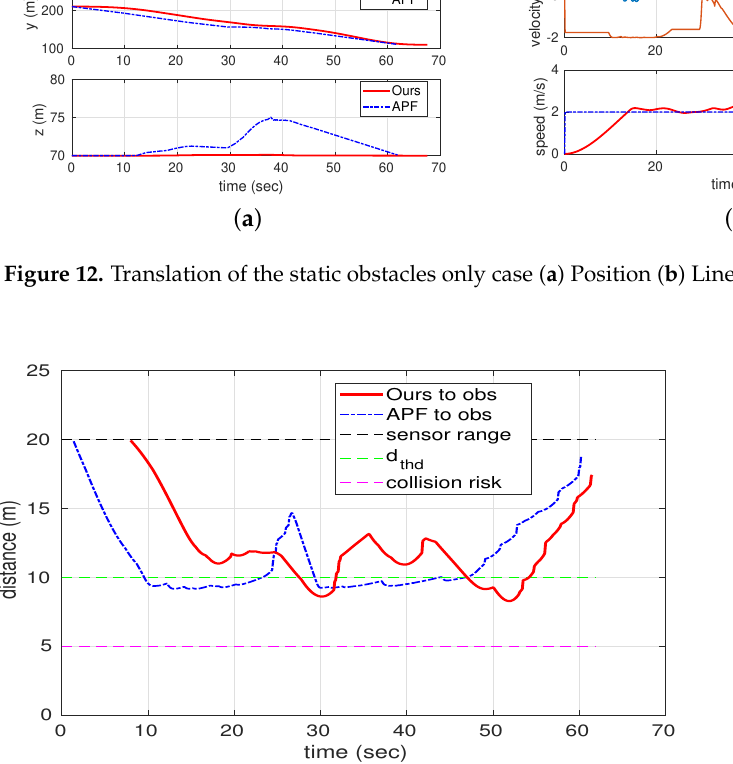
Figure 13. Relative distance to the nearest obstacle in the static obstacles only